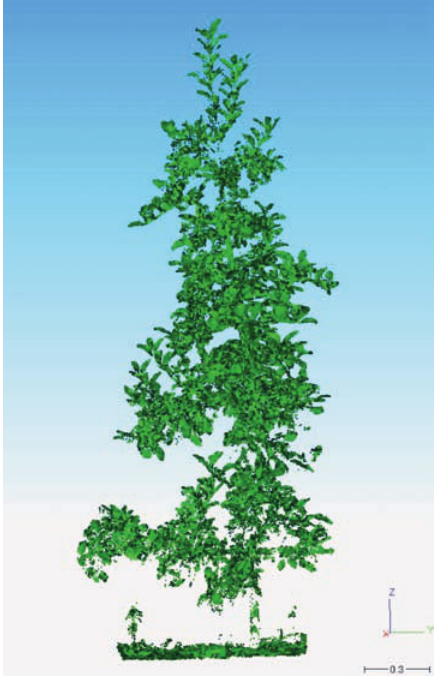
Figure 2: Model of a chosen apple